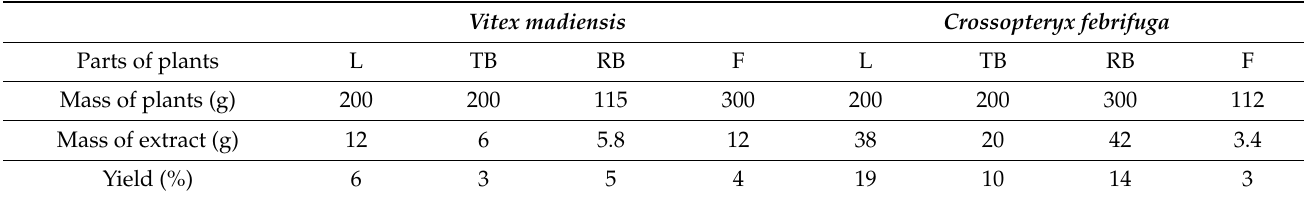
Table 4. Yield of methanolic extraction of each part of plants (L: leaves, TB: trunk bark, RB: root bark, F: